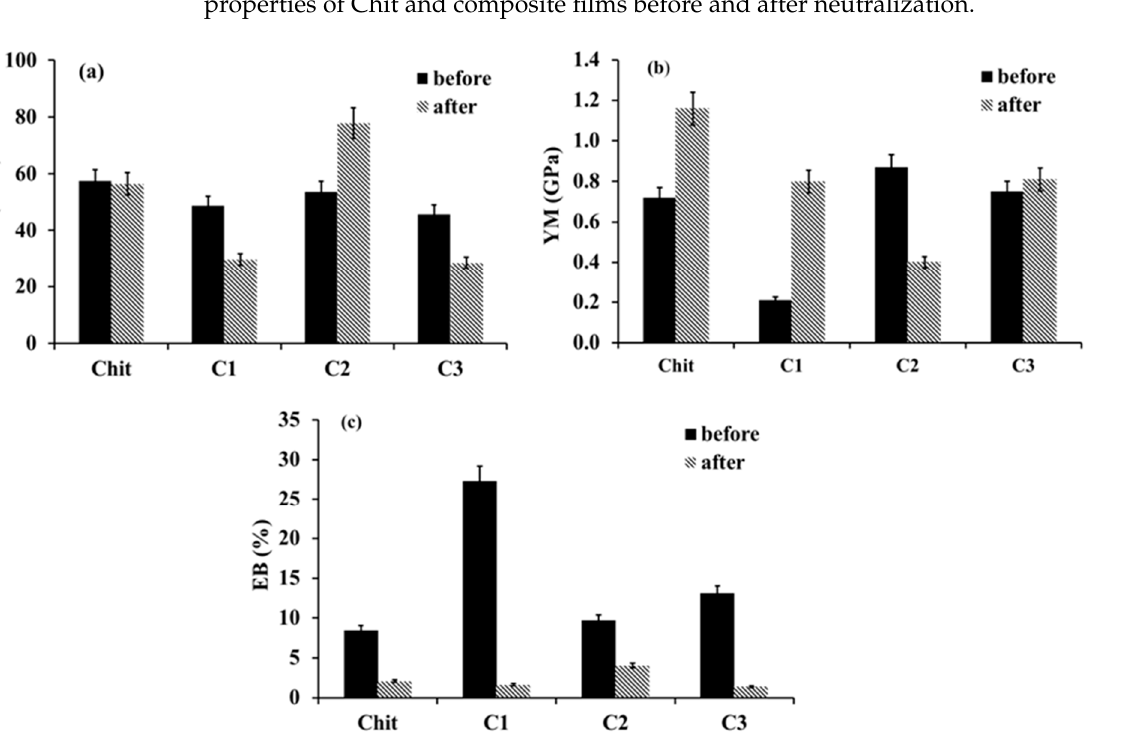
Figure 2. Mechanical properties of Chit and Chit composite films: ( a ) TS, ( b ) YM, and ( c ) EB, before and after alkaline treatment, n = 5, mean ± SD (standard deviation), error bars represent SD. It is observed that Chit composite films before alkaline treatment exhibit YM values ranging from 0.21 GPa ± 0.02 to 0.87 GPa ± 0.06 (Figure 2) compared to Chit films (0.72